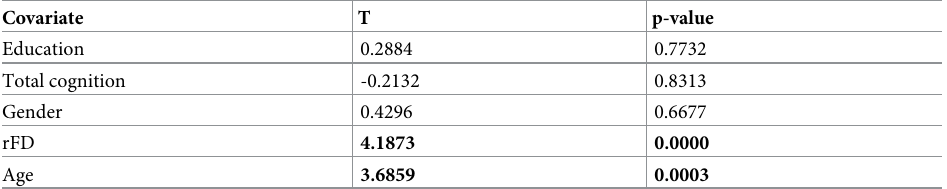
Table 4. Linear regression of subject-wise residual sum of squares of thickness signal orthogonal to the derived education-related thickness pattern. In-scanner movement (= rFD) and age were associated positively with residual thickness